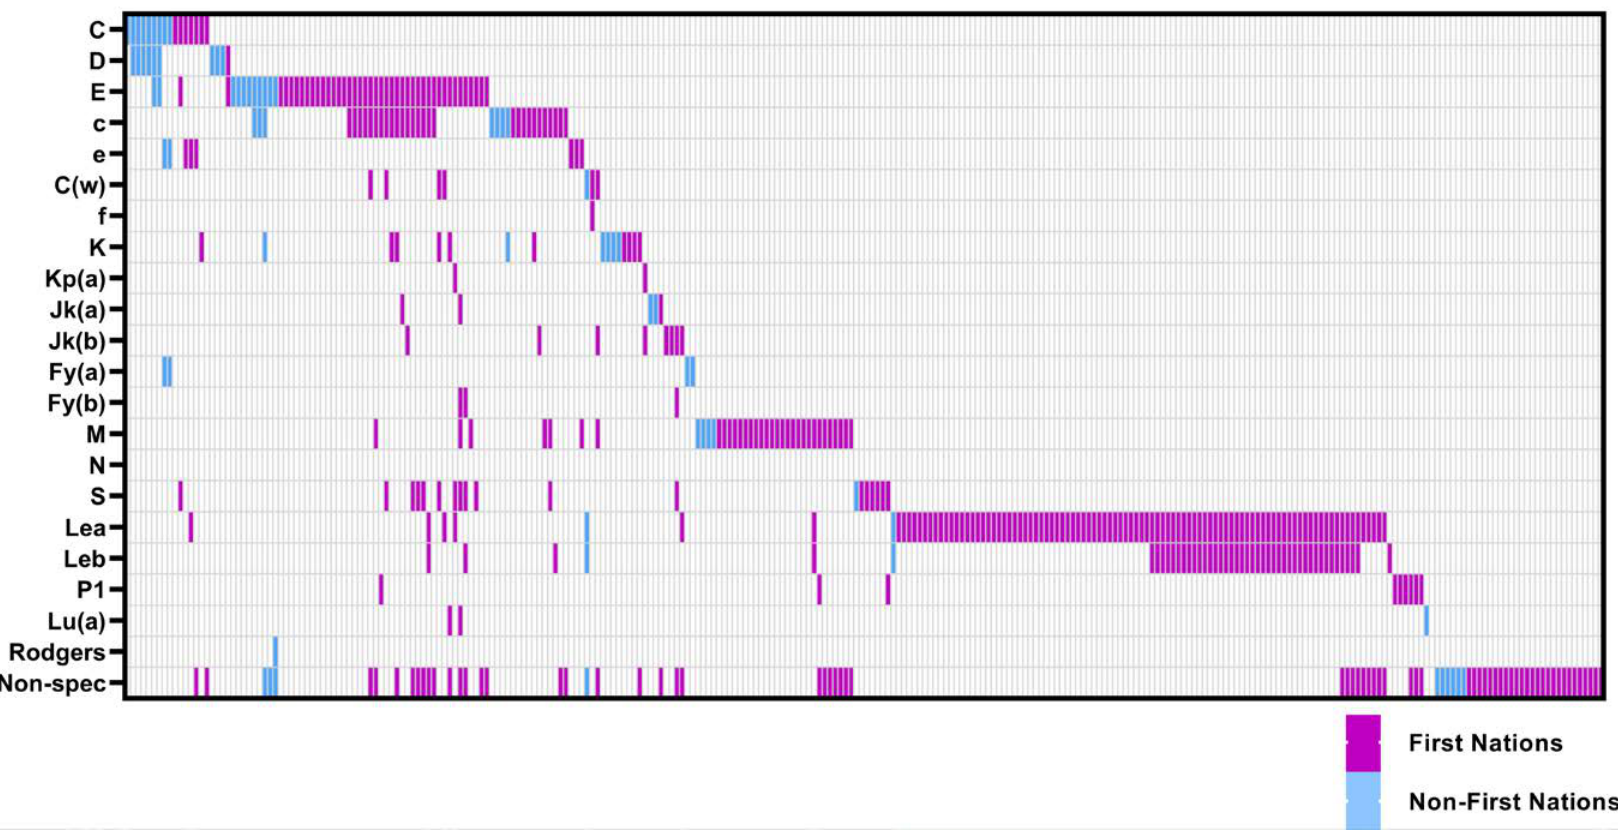
Figure 3. Distribution (specificity) of red cell alloantibodies in NT ICU patients (n = 280), First Nations (n = 232) versus non-First Nations (n = 48) patients. Each column represents an individual alloantibody-positive patient. Non-spec: non-specific agglutinin/antibody.